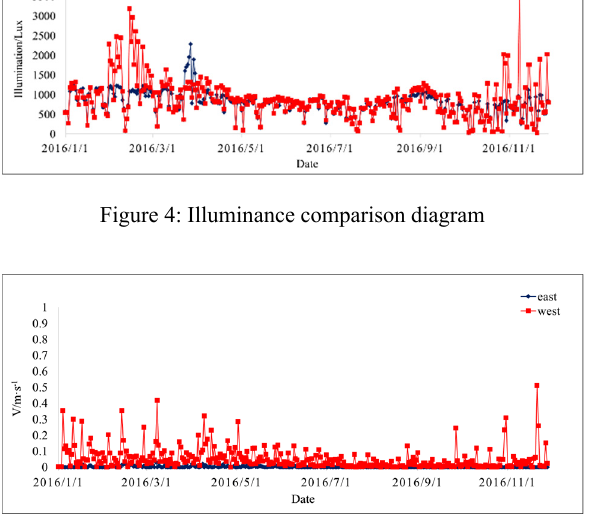
Figure 5: Wind speed comparison diagram